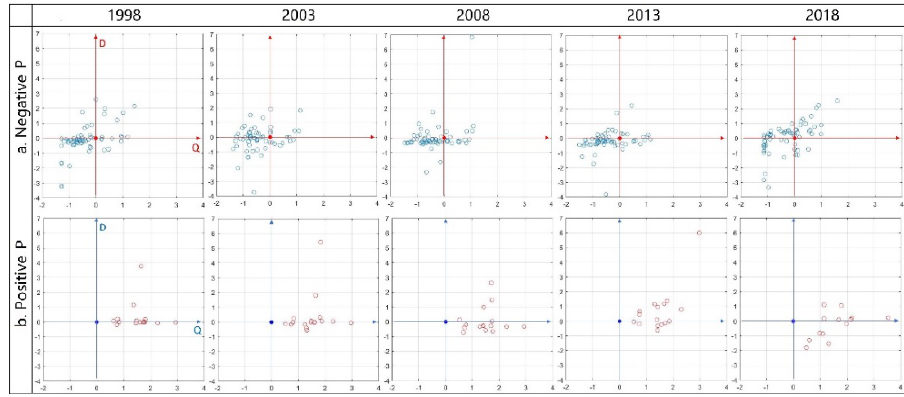
Figure 13. Multidimensional assessment results projected on P plane at the county